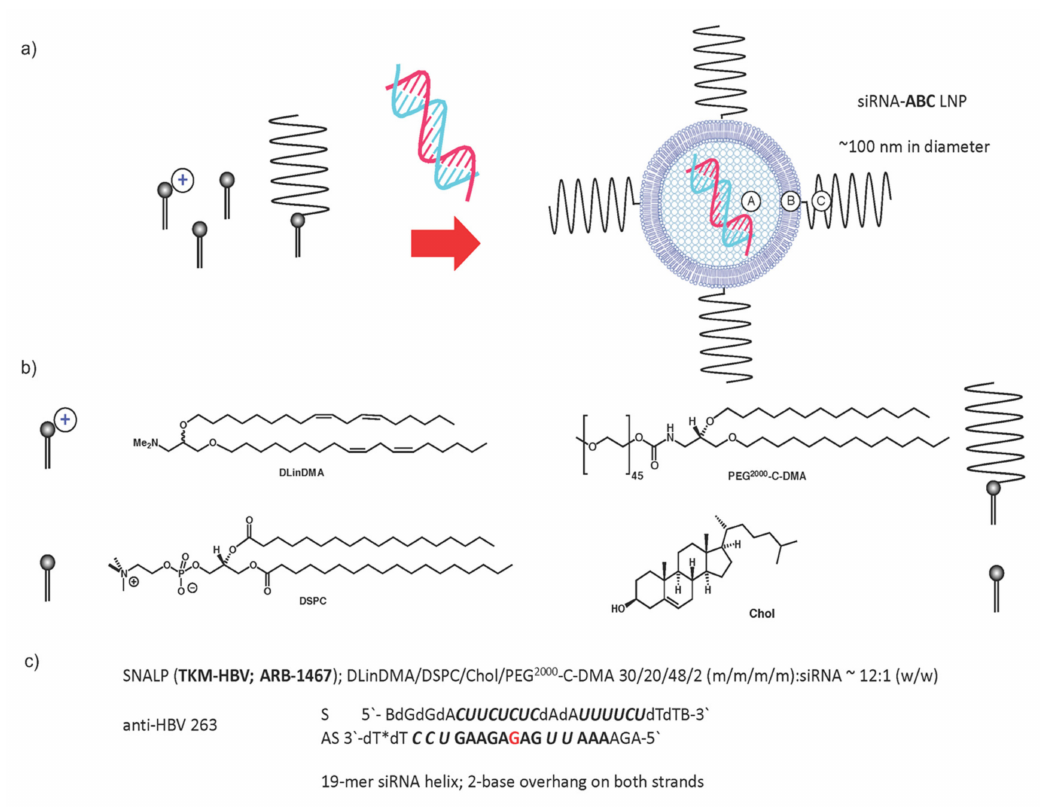
Figure 5. Schematic of TKM-HBV LNPs. The formulation ( a ) of these siRNA-ABC LNPs results from a combination of siRNA-API anti-HBV 263 and lipid self-assembly, involving one ionizable, two neutral, and one PEGylated lipid, as shown in ( b ). In ( c ), the mol fractions of each lipid combination are indicated, as is the approximate ratio of lipid to siRNA in the fully formulated ABC LNP. The structure of anti-HBV 263 is highly chemically-modified. Chemical modifications are indicated as follows: dN are 2 (cid:48) -deoxynucleoside residues (dT: 2 (cid:48) -deoxythymidine; dU: 2 (cid:48) -deoxyuridine; dC: 2 (cid:48) -deoxycytidine; dA: 2 (cid:48) -deoxyadenosine; dG: 2 (cid:48) -deoxyguanidine), B is 3 (cid:48) , 5 (cid:48) inverted deoxy abasic residue, bold italic letters are 2 (cid:48) -F residues, bold letters are 2 (cid:48) -OMe residues. The red letter denotes the putative nucleoside cleavage site residue position (10) in the antisense strand (AS) that acts as a guide strand for guiding the process of RNA silencing while the complementary sense strand (S) acts just as a passenger